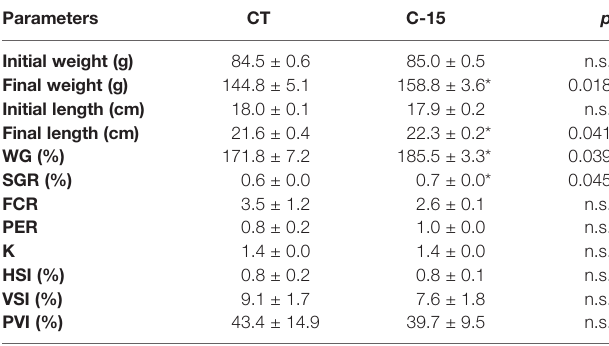
TABLE 3 | Growth performance and somatic indices of juvenile C. labrosus fed control (CT) and C-15 diets during 90 days. Parameters